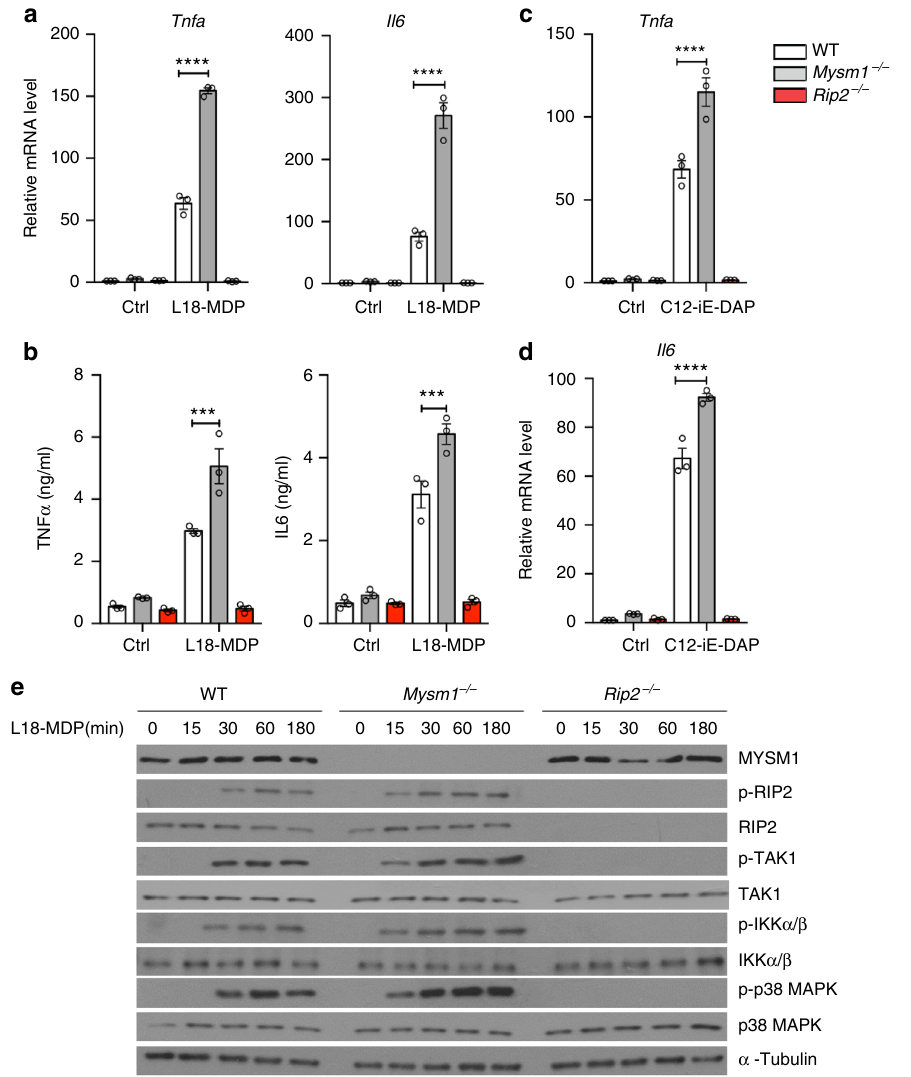
Fig. 3 MYSM1 suppresses proximal NOD2 signaling events and cytokine response. a , b WT, Mysm1 − / − , and Rip2 − / − BMDMs, either unstimulated (Ctrl) or stimulated with L18-MDP (200 ng/ml), were analyzed by qRT-PCR for Tnfa and Il6 transcript 6 h post stimulation ( a ) or for secreted TNF- α and IL-6 12 h post stimulation ( b ). c , d WT, Mysm1 − / − , and Rip2 − / − BMDMs, either unstimulated (Ctrl) or stimulated with C12-iE DAP (200 ng/ml), were analyzed by qRT-PCR for Tnfa ( c ) and Il6 ( d ) transcript 6 h post stimulation. Results in ( a – d ) are from three independent experiments. Data are shown as mean ± s.e.m. ( n = 3). *** p < 0.001 determined by one-way ANOVA followed by Bonferroni ’ s post-test depicts statistical signi fi cance. e WT, Mysm1 − / − and Rip2 − / − BMDMs, either unstimulated (Ctrl) or stimulated with L18-MDP for indicated duration, were analysed by immunoblotting for MYSM1, p-RIP2, RIP2,